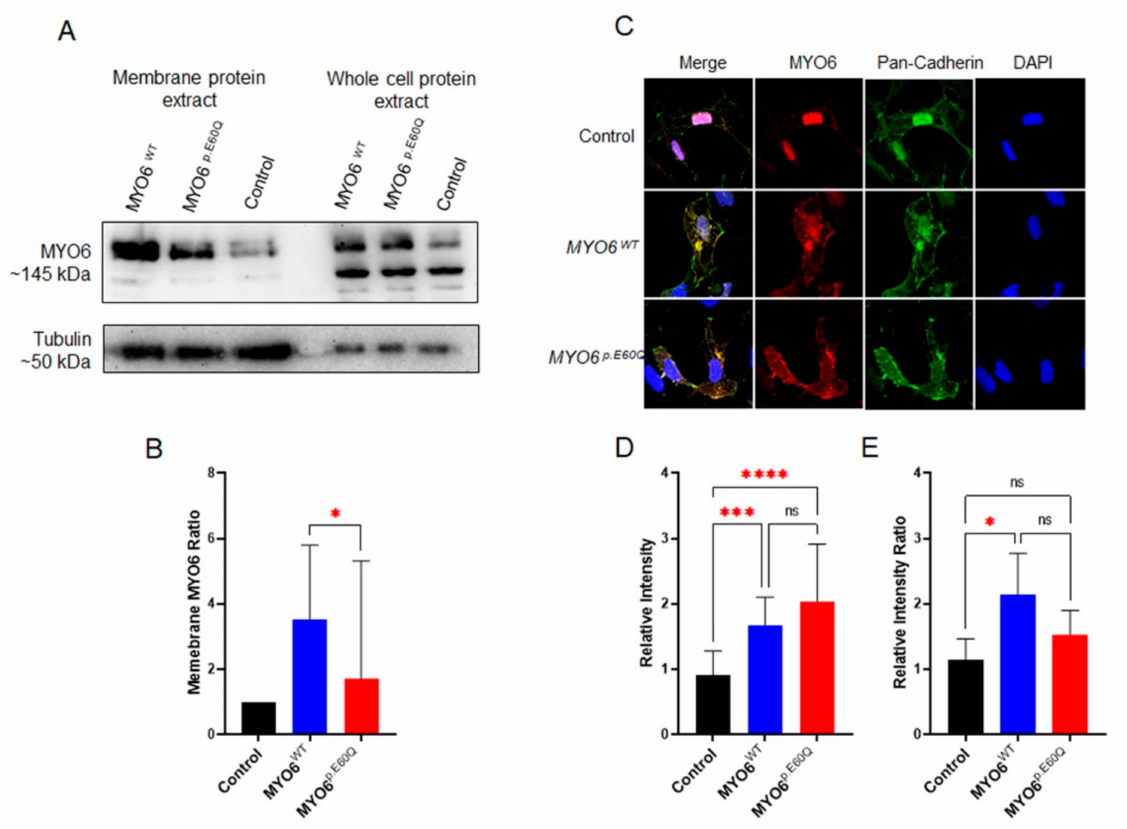
Figure 3. Cellular analysis of novel MYO6 variant. ( A ) Western blot of whole-cell lysates and membrane proteins from HeL a cells transfected with plasmids carrying human MYO6 WT and MYO6 p.E60Q . ( B ) Quantification ratio of the normalized integrated density of MYO6 expression from membrane/whole proteins. ( C ) Representative immunofluorescence staining images of HeLa cells labeled by MYO6 (red), pan-cadherin (green), and DAPI (blue). ( D ) Quantification of the relative fluorescence intensity of MYO6. ( E ) Quantification of the ratio of the normalized relative fluorescence intensity of MYO6/pan-cadherin. All values are represented as the mean ± SEM from independent experiments. Statistically significant differences were assessed by ( B ) unpaired t -test, * p < 0.05 or ( D , E ) one-way ANOVA followed by Tukey’s multiple comparisons, * p < 0.05; *** p = 0.0001; **** p <